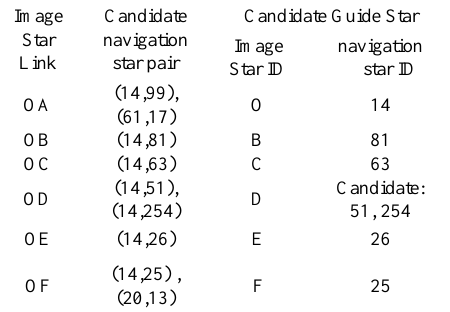
Table 1 The statistic of Appearance